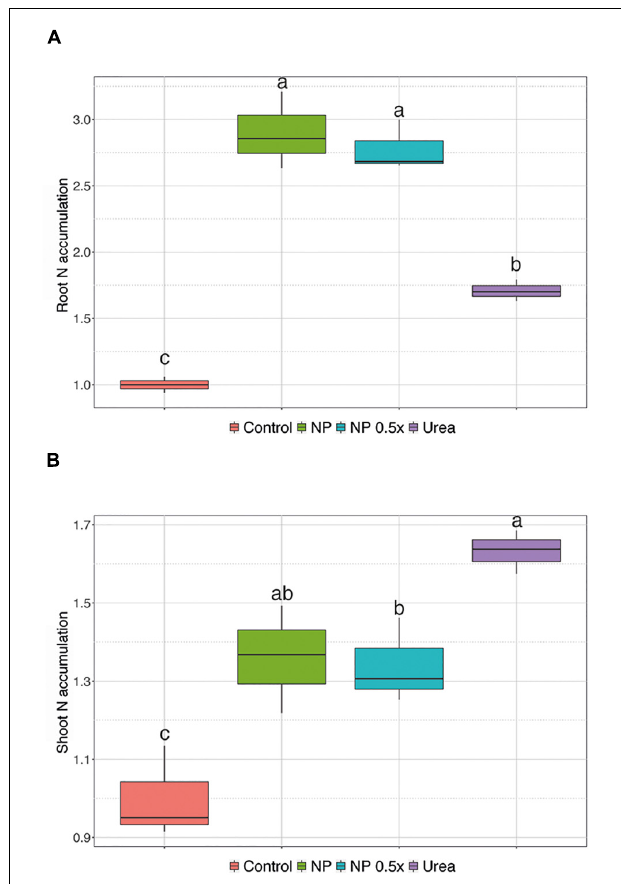
FIGURE 4 | Total nitrogen (N) content. Accumulation of N in (A) root and (B) shoot of cucumber plants either not treated (control) or supplied with 1 mM Urea, NP, or NP.5 × . The assessments have been carried out at harvest (i.e., 7 days after the treatments as depicted in Supplementary Figure 2C ) on at least six independent biological replicates. N accumulation has been calculated as the ratio between the concentration assessed in the treated plants and that determined in control samples. Different letters indicate significantly different values as determined by one-way ANOVA with Tukey post hoc tests ( P <